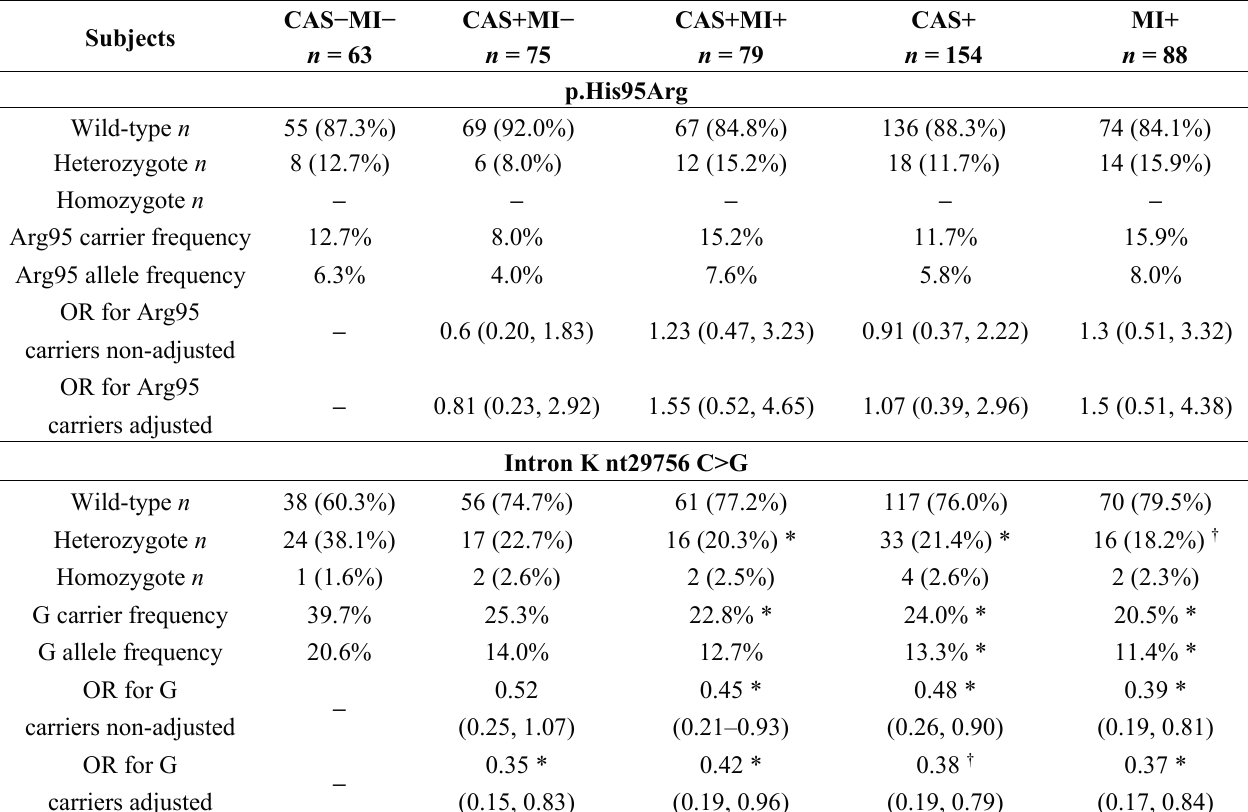
Table 3. The effect of FXIII-B p.His95Arg and intron K nt29756 C>G polymorphisms on the risk of coronary artery disease in patients with an elevated fibrinogen